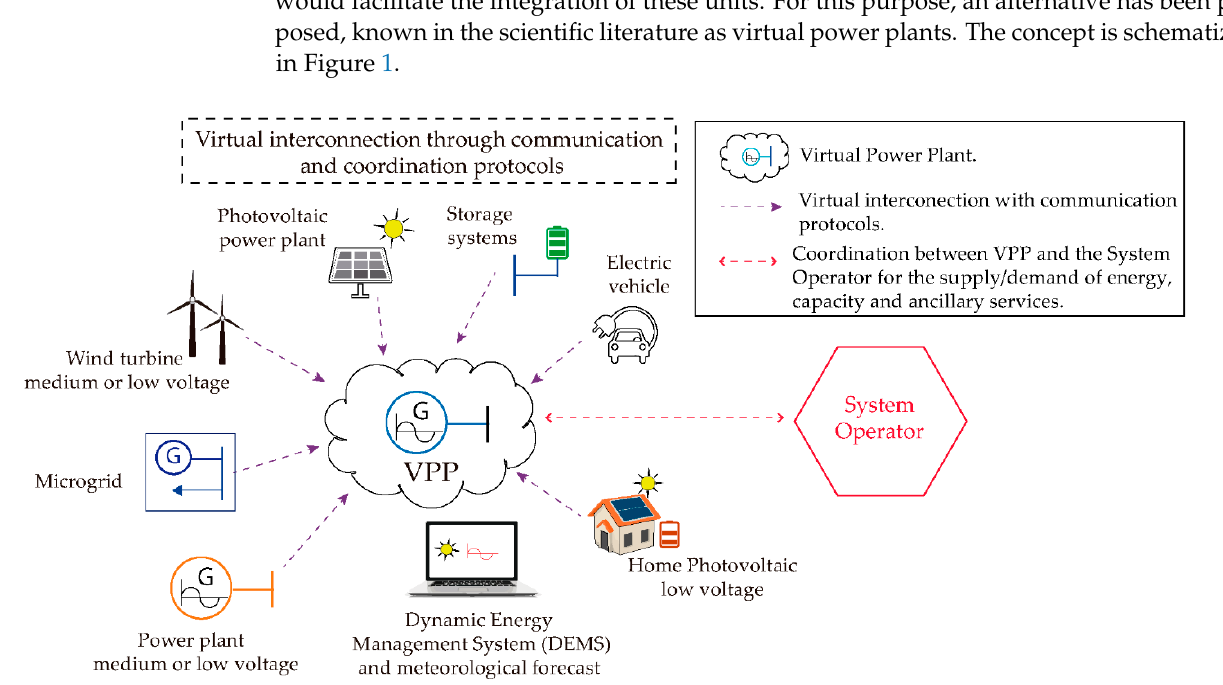
Figure 1. Virtual power plant as a strategy to facilitate the integration of DERs in the power system.